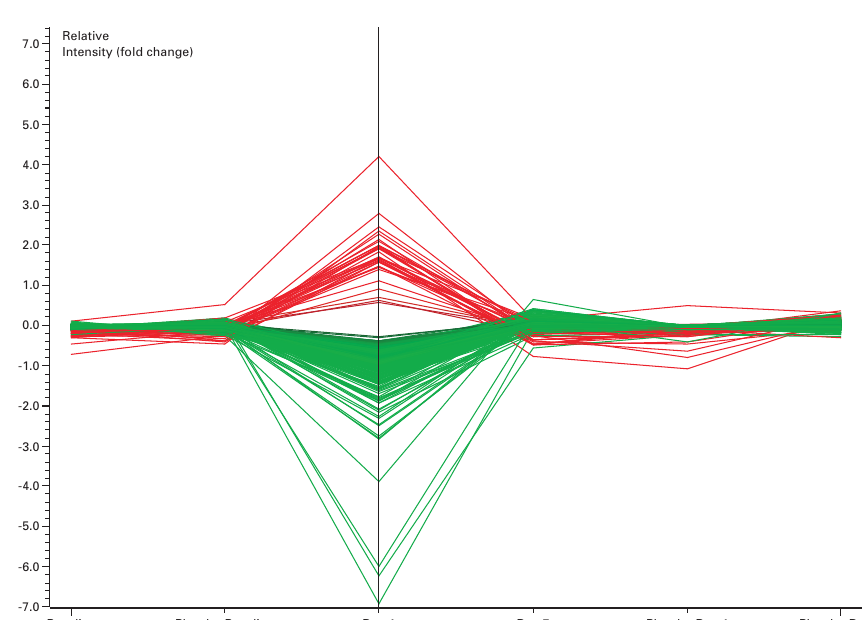
Baseline Placebo Day 7Placebo Baseline